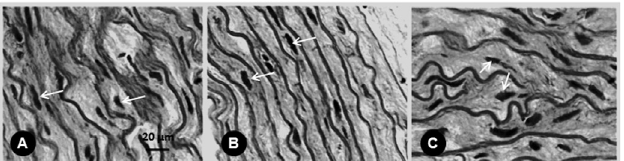
Figure 5. Photomicrographs of the aortic wall sections stained with hematoxilyn-eosin. The numbers of cell nuclei (arrows) in OC (B) and OT (C) groups are greater than in MA group (A).